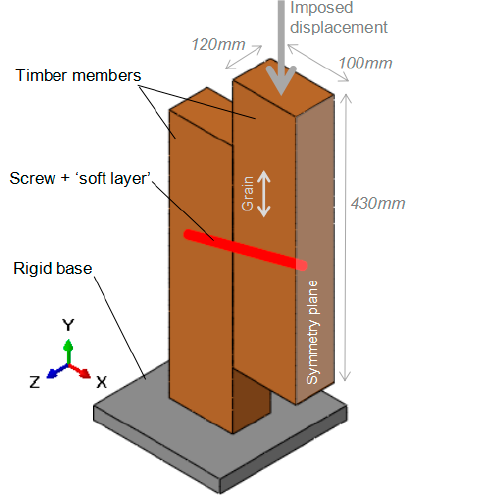
Figure 4. Reference FE numerical model for TTC joints with inclined STSs under a standard PO setup (S#1, α = − 15°).